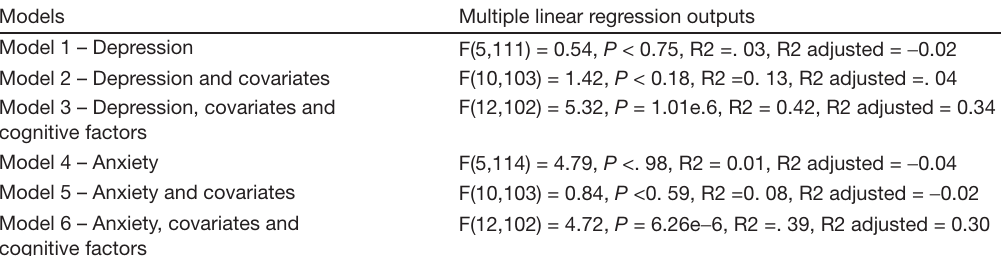
Supplementary Table 3. Multiple linear regression